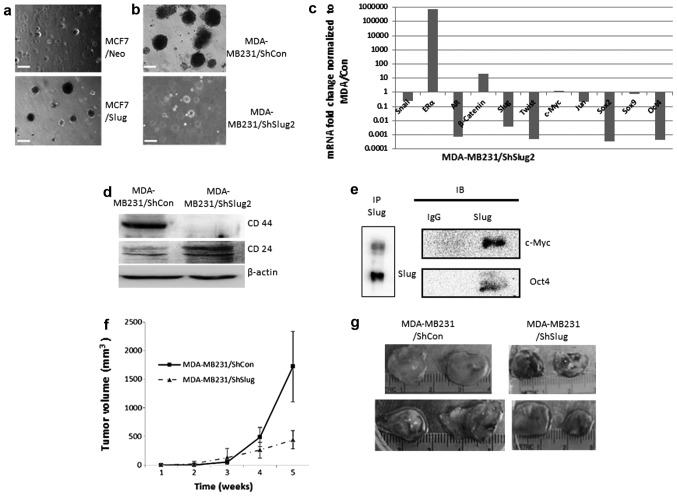
Slug promotes tumor formation and metastasis. (a) MCF7 cells, after 72-h transient transfection with Neovector control or Slug plasmid, were subjected to Matrigel colony formation assay. The images show the colonies after 2 weeks in culture. (b) MDA-MB-231 cells, stably transfected with ShControl or ShSlug plasmid, were subjected to Matrigel colony formation assay. The images show the colonies after 2 weeks in culture. The MDA-MB-231/ShSlug2 is a single colony selection number 2. Scale bars in a and b represent 200 μm. (c) The mRNA levels of the transcription factors were compared between MDA-MB-231/ShCon and MDA-MB-231/ShSlug2 by qRT-PCR. GAPDH was used as a loading control. (d) The protein expression level of breast CD24 and CD44 in MDA-MB-231/ShCon and MBA-MB-231/ShSlug. Cell extracts (50 μg) were loaded in each lane, and the membranes were probed with anti-CD24, CD44 and β-actin antibodies to detect the protein. (e) Co-immunoprecipitation (co-IP) between Slug with c-Myc and Oct4. Co-IP was performed with anti-Slug and IgG control antibodies followed by immunoblotting with anti c-Myc and Oct4 antibodies. The nuclear extracts were used in the immunoprecipitation step. (f) Tumor growth curves for xenografs arise from implanting 1×106 cells of MDA-MB-231/ShCon and MDA-MB-231/ShSlug2. (g) Images of xenografts that arise from implanting 1×106 cells.